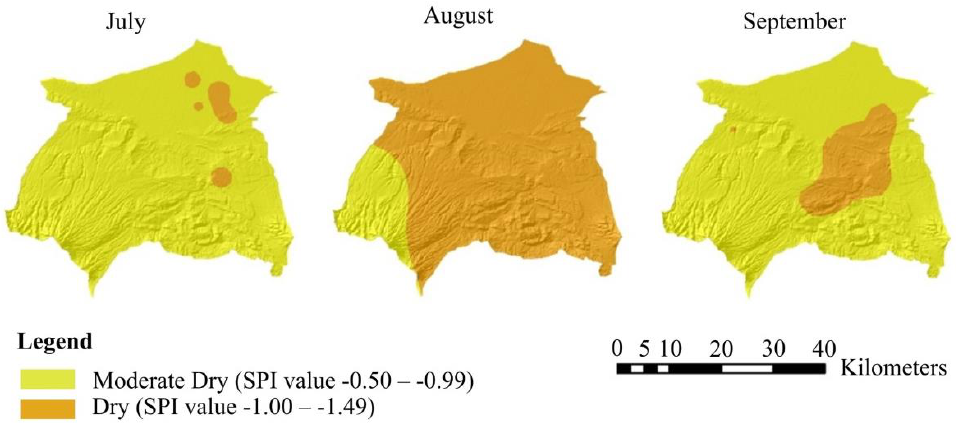
Figure 9. Spatial monthly SPI distribution in the Bodri-Kuto river basin.